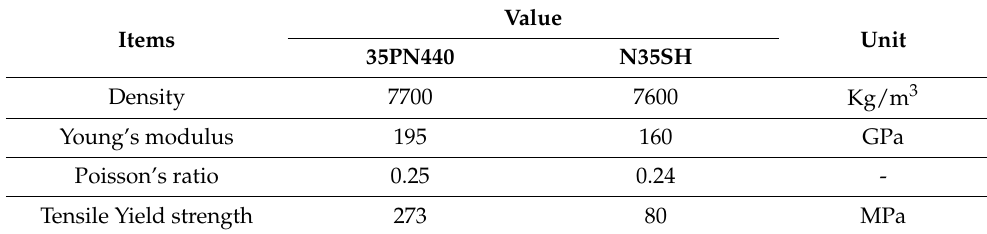
Table 2. Rotor core and magnet material properties.